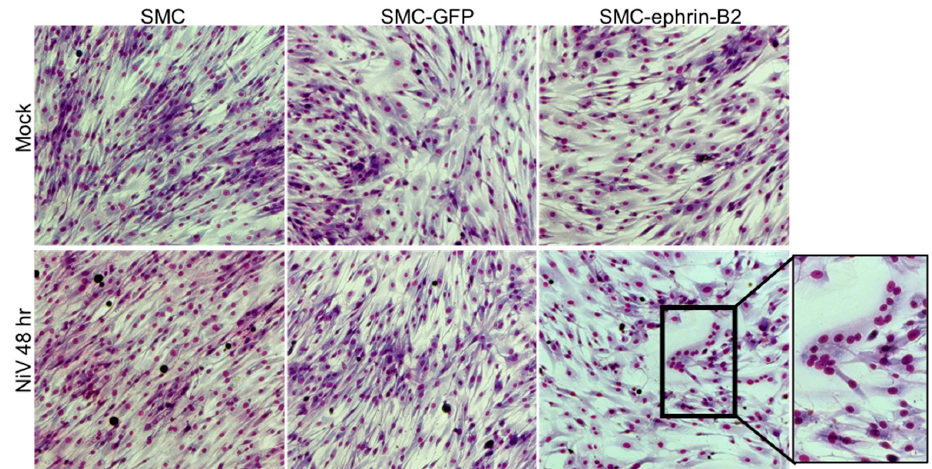
Figure 5. SMC transfected with a plasmid encoding ephrin-B2 can fuse following infection with NiV. SMCs were either mock transfected or transfected with plasmids expression either GFP or ephrin-B2. Following transfection, cells were exposed to NiV at a MOI of 5 or mock-infected (top row). At 48 h, cells were fixed with Kwik-Diff for visualization. Insets highlight morphologic changes. Images were captured at 10× magnification.